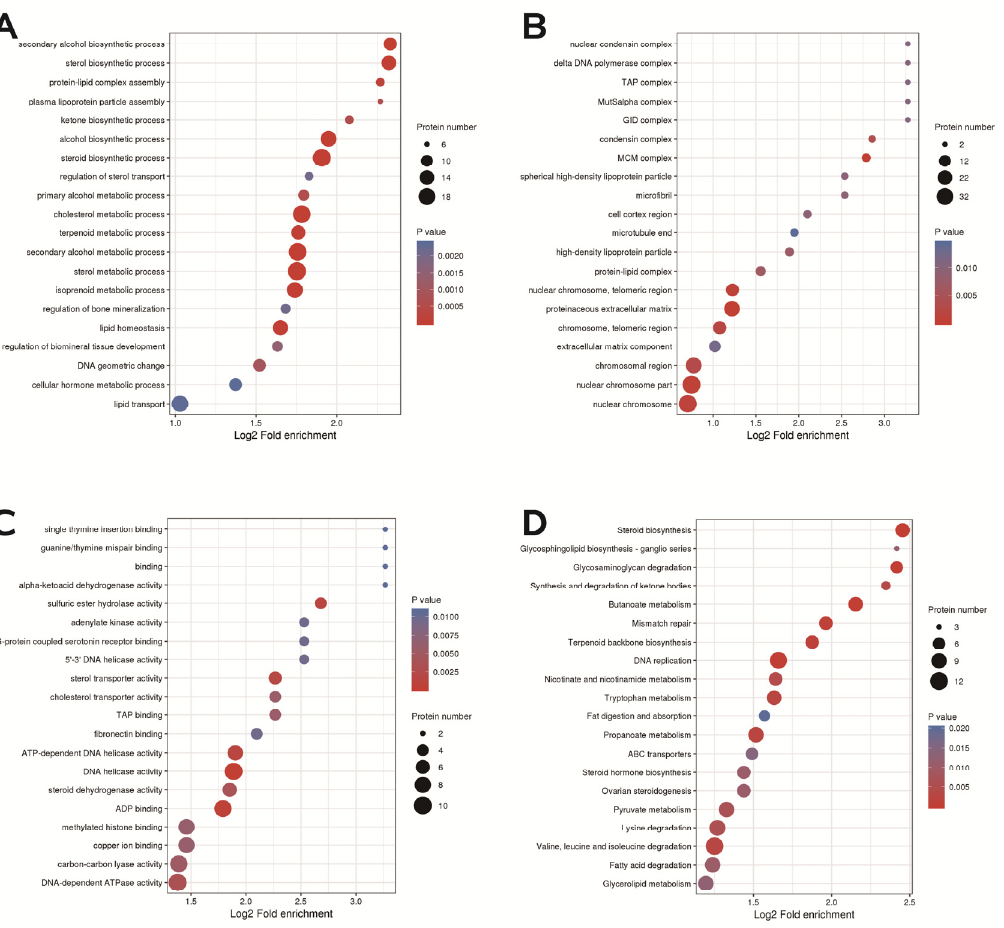
Figure 9. GO enrichment and KEGG pathway enrichment. ( A ) Distribution of biological processes of di ff erentially expressed proteins. ( B ) Distribution of cellular components of di ff erentially ex- pressed proteins. ( C ) Bubble diagram of molecular function distribution of di ff erentially expressed proteins. ( D ) Bubble diagram of the enrichment distribution of di ff erentially expressed proteins in the KEGG pathway.